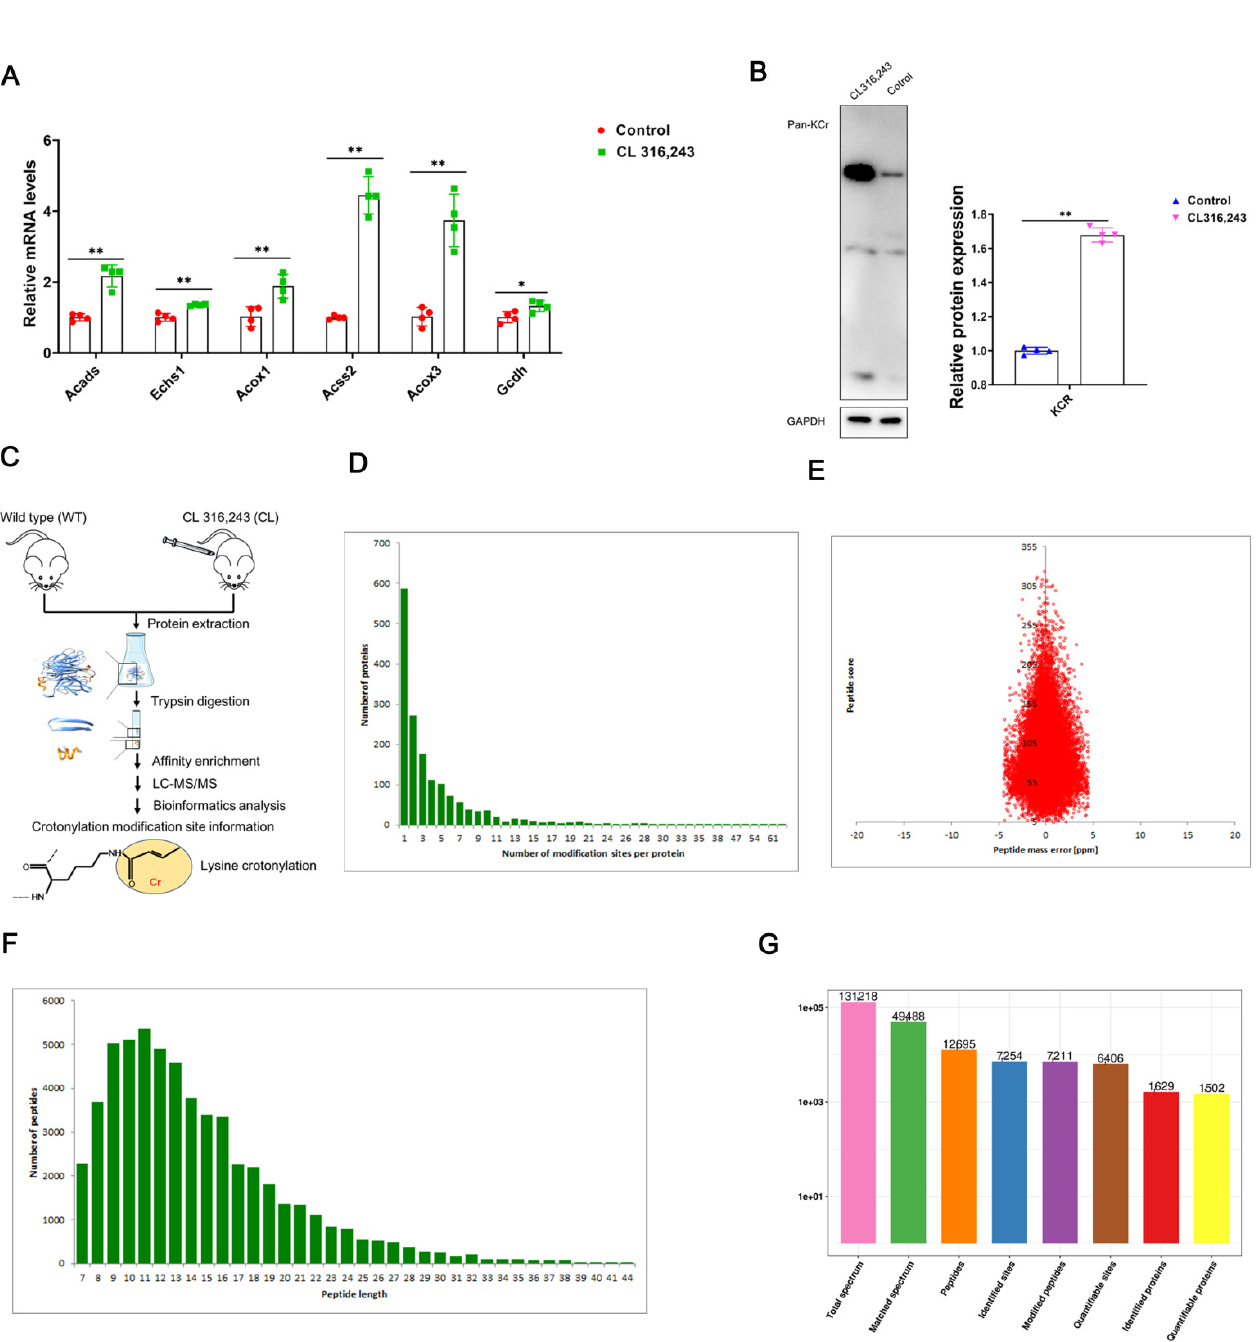
Figure 2. Sequencing of non-histone crotonylation modifications. Note: After the mice were injected with CL316,243 for 4 weeks and stabilized, the mouse iWAT samples were extracted and sent to the company for affinity analysis and LC-MS/MS, combined with database search and bioinformatics analysis. ( A ) The mRNA expression levels of crotonylation-related genes acyl-CoA dehydrogenase short chain (Acads), enoyl-CoA hydratase, short chain 1 (Echs1), acyl-CoA oxidase 1 (Acox1), acyl-CoA synthetase short chain family member 2 (Acss2), acyl-CoA oxidase 3 (Acox3) and glutaryl-CoA dehydrogenase (Gcdh) [34] ( n = 4). ( B ) Protein crotonylation modification level ( n = 4). ( C ). Schematic diagram of label-free quantitative proteomics of crotonylation. ( D – F ) Detection and analysis of sample quality ( n = 3). ( G ) LC-MS/MS spectral library search analysis summary, overview of differentially modified modification sites (modified proteins), standardized differential modification site (modified protein) summary ( n = 4). * p < 0.05, ** p < 0.01.